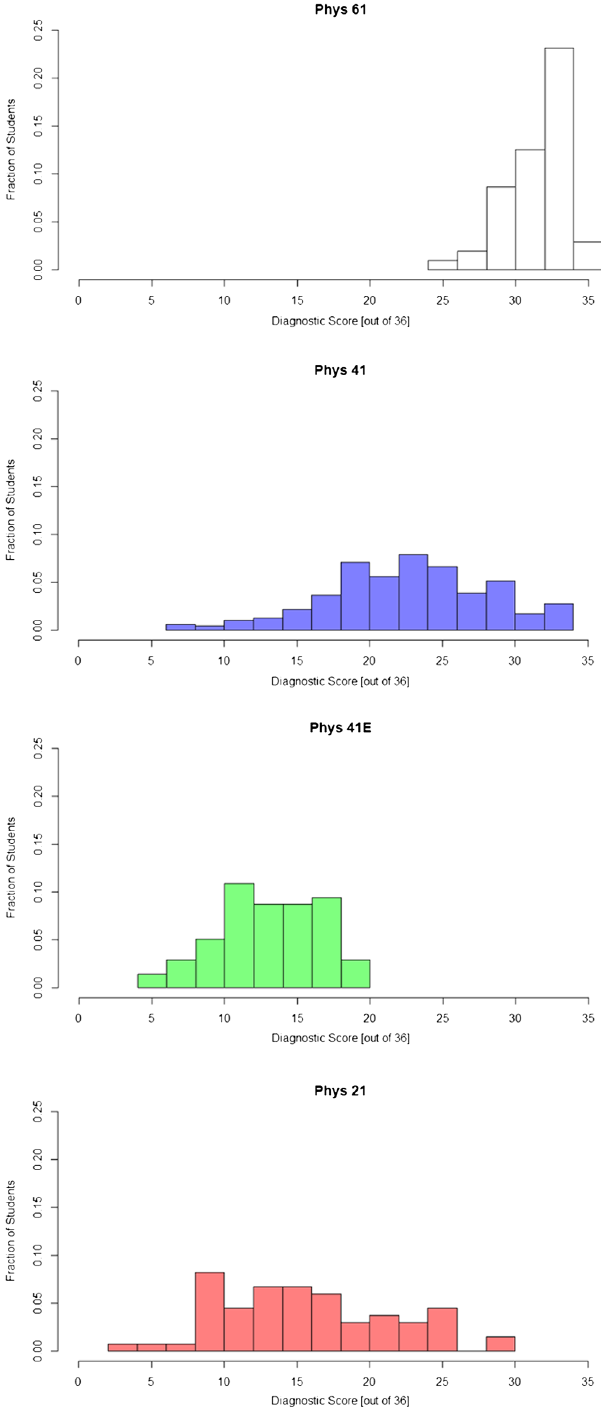
FIG. 1. Histogram of diagnostic scores for students in the honors course (Phys 61), standard calculus-based course (Phys 41), calculus-based course for poorly prepared students (Phys 41E), and algebra-based course (Phys 21).